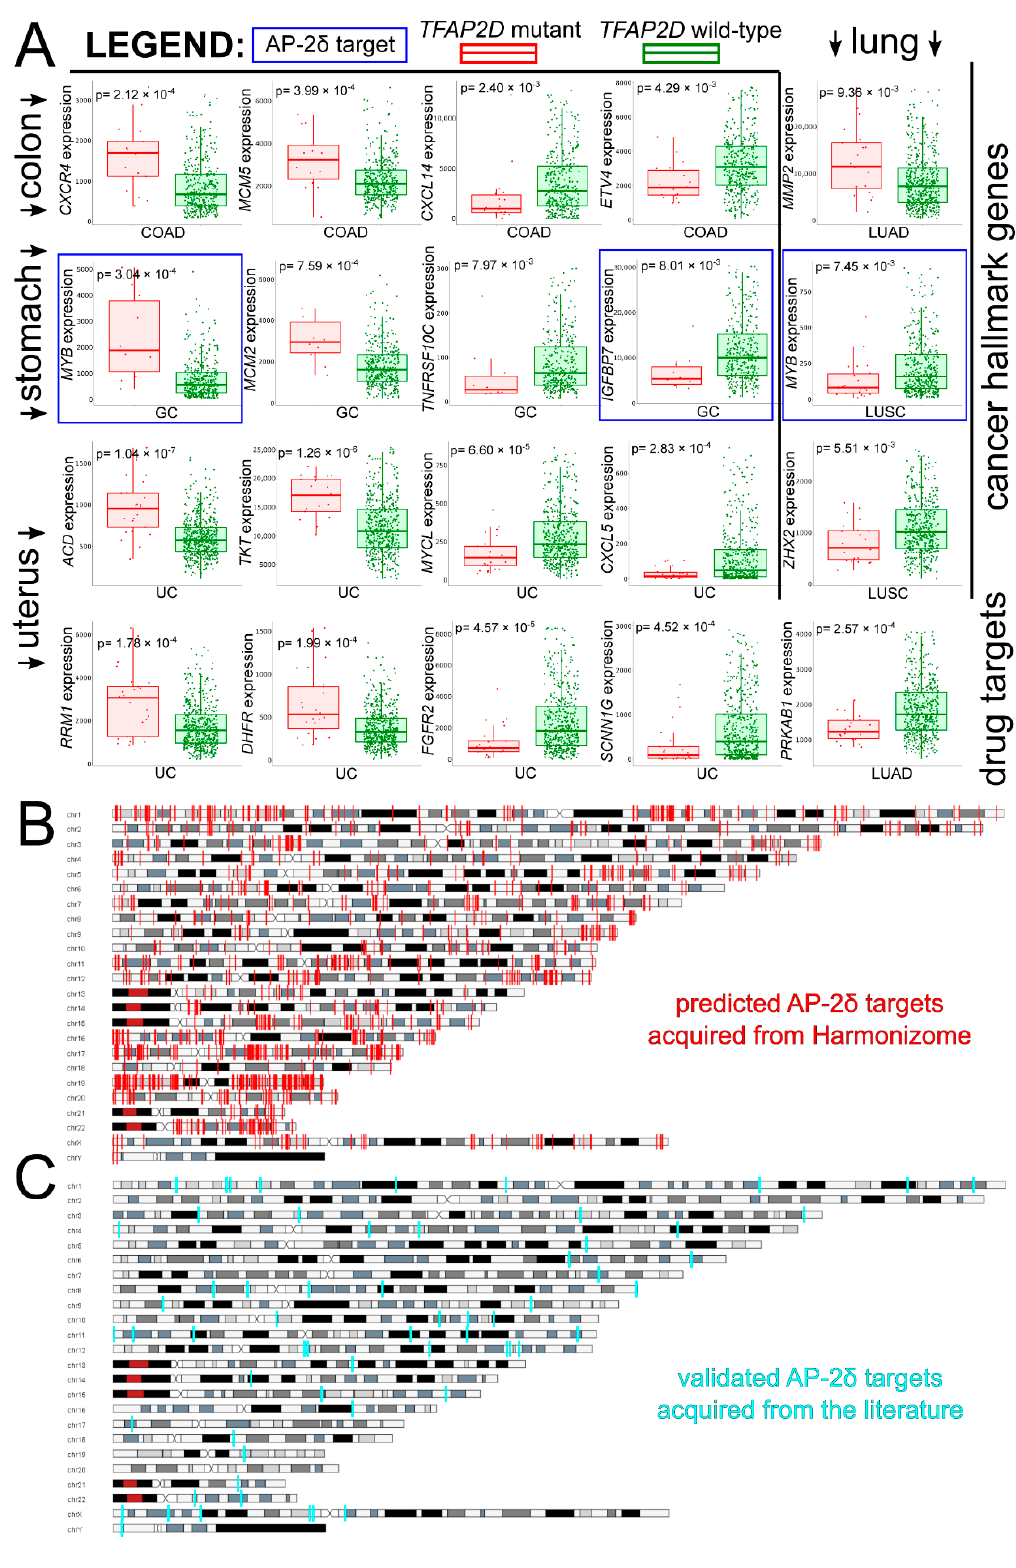
Figure 7. Investigation of AP-2 δ mutational status via muTarget and visualization of AP-2 δ genetic targets through Ideogram Viewer. ( A ) The best cancer hallmark genes and FDA-approved drug targets of which expression co-dependence occurs with TFAP2D mutation status (complete list available in Supplementary Materials). Genes identified as AP-2 δ genetic targets are framed in blue. ( B ) Genomic location of predicted AP-2 δ targets (marked in red). ( C ) Genomic location of validated AP-2 δ targets (marked in cyan).